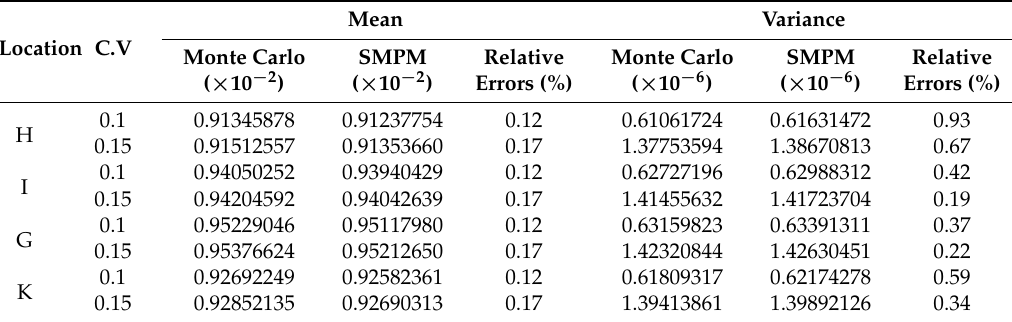
Table 6. The mean and variance of the equivalent plastic stress σ y .